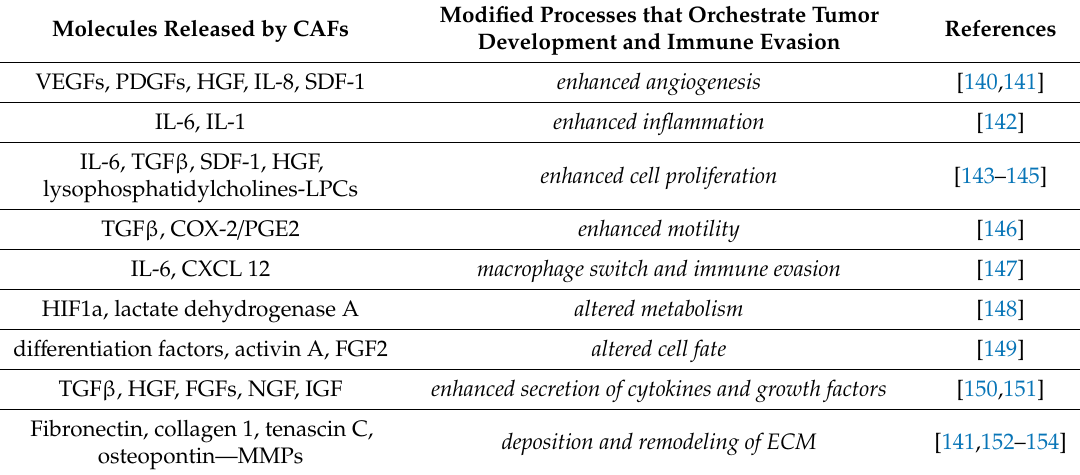
Table 2. Cancer-associated fibroblasts regulate cancer progression through a dynamic secretome. Molecules Released by